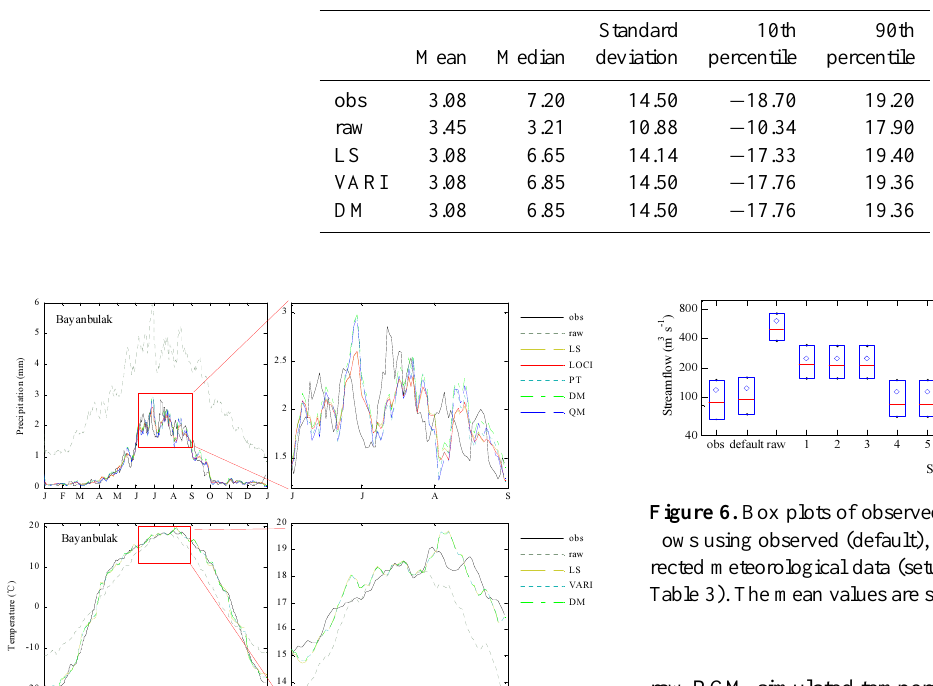
Table 5. Frequency-based statistics (unit: ◦ C) of daily observed (obs), raw RCM-simulated (raw) and bias-corrected maximum temperatures at the Bayanbulak Station.